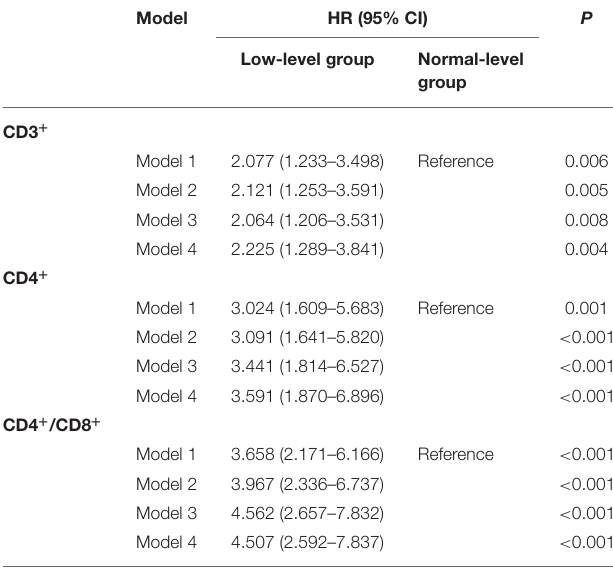
TABLE 2 | Associations of CD3 + , CD4 + , and CD8 + T cells with major